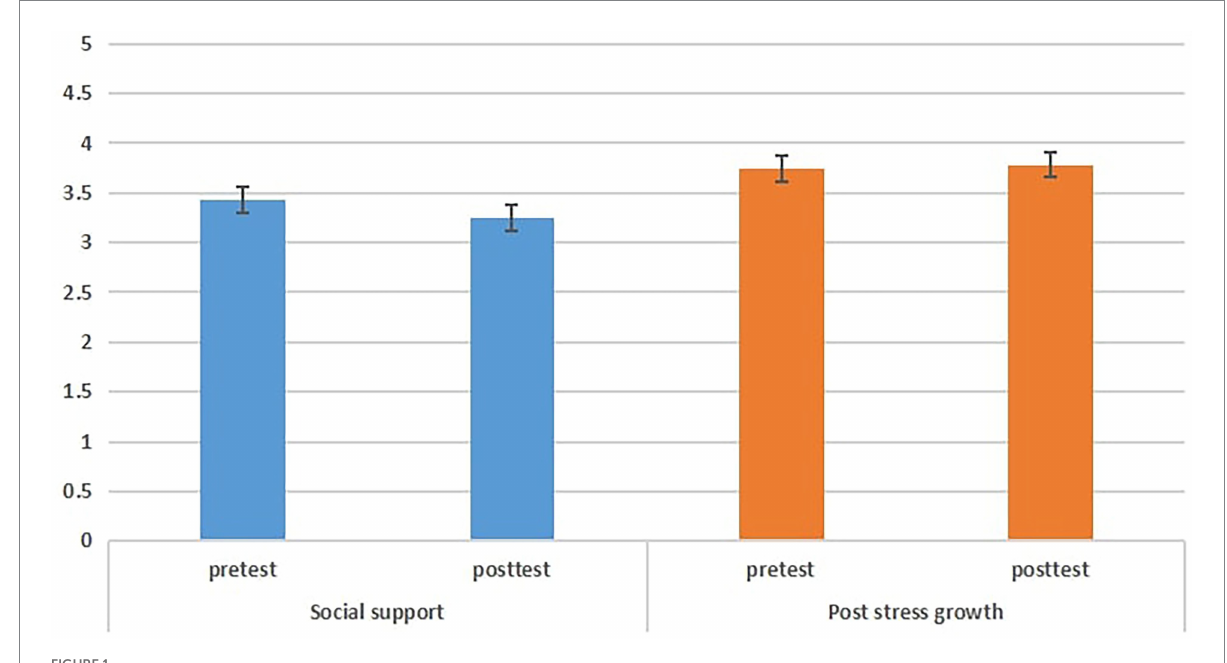
FIGURE 1 Comparison of pretest and posttest differences in the control